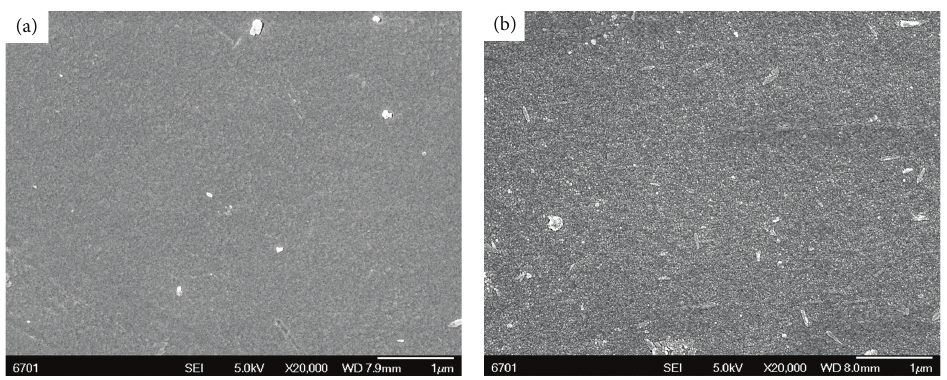
Figure 4: SEM images of M-PAANa modified by different monomer concentration: (a) 0.09 mol/L and (b) 0.9 mol/L.